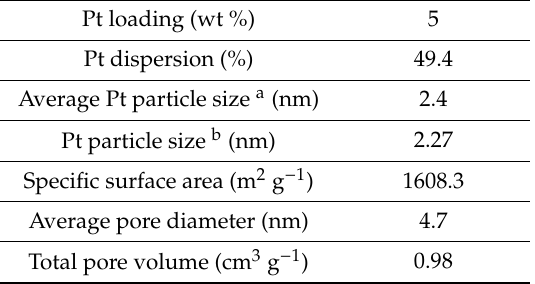
Table 2. Physicochemical properties of the activated carbon-supported Pt (Pt / AC)